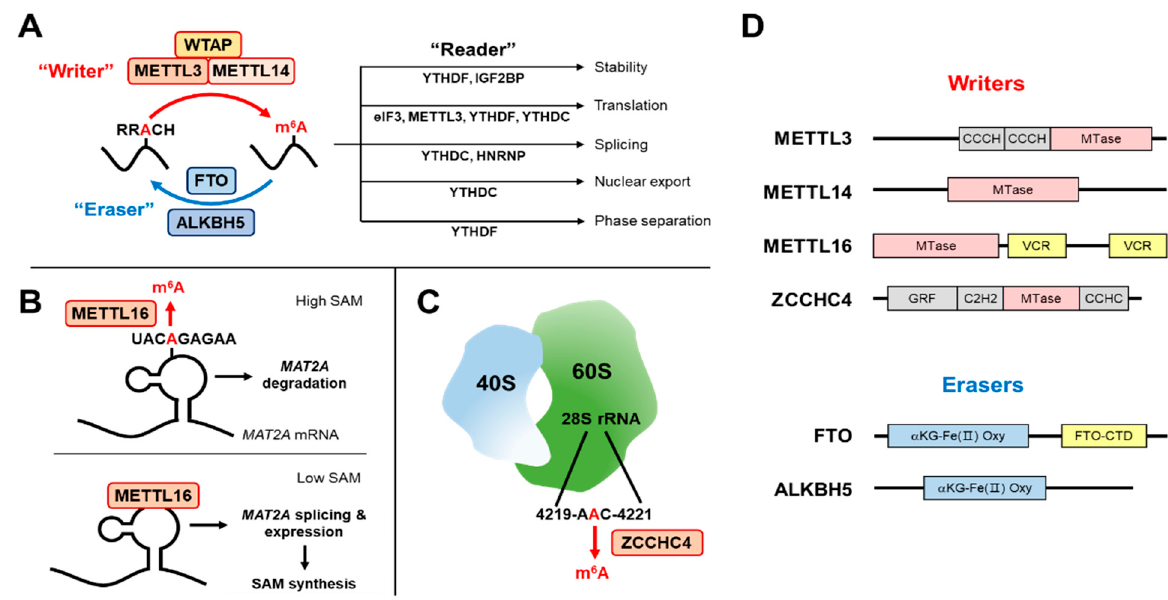
Figure 1. N 6 -methyladenosine (m 6 A) methylation process and its biological functions. ( A ) m 6 A writers (methyltransferase) methylate RNA in the adenine nucleobase of amino group at N 6 position. The consensus motif of methyltransferase-like 3 (METTL3) is RRA*CH (R = A/G; A* = methylated A; H = A/C/U). Once m 6 A is deposited on RNA, m 6 A reader proteins are recruited and determine RNA fates, such as splicing, stability, and translation efficiency, which ultimately affect gene expression. m 6 A is removed from RNA through demethylation by eraser proteins. ( B ) METTL16 methylates stem-loop structure in 3’ untranslated region (UTR) of S -adenosyl methionine (SAM) synthase, methionine adenosyltransferase 2A ( MAT2A ). In SAM-repleted conditions, MAT2A is methylated and degraded. Oppositely, in SAM-depleted conditions, METTL16 induces splicing and expression of MAT2A . ( C ) Methylation of A4220 in 28S ribosomal RNA (rRNA) by zinc finger CCHC domain-containing protein 4 (ZCCHC4) promotes ribosome assembly and translation. ( D ) Domain composition of m 6 A enzymes. (Top, writers) m 6 A writers contain methyltransferase (MTase) domains. METTL3 contains Cys-Cys-Cys-His (CCCH) zinc finger motifs. METTL16 has two vertebrate conserved region (VCR) domains in C-terminus. ZCCHC4 possesses several zinc finger motifs, including Gly-Arg-Phe (GRF), Cys2-His2 (C2H2), and Cys-Cys-His-Cys (CCHC) domains. (Bottom, erasers) Fat mass and obesity-associated protein (FTO) and alkb homolog 5 (ALKBH5) contain α KG- Fe(II)-dependent dioxygenase domains conserved in dioxygenase family enzymes. WTAP, Wilms’ tumor 1-associated protein; eIF3, eukaryotic initiation factor 3; YTHDF, YTH domain family; YTHDC, YTH domain-containing protein; IGF2BP, insulin-like growth factor 2 mRNA-binding protein; HNRNP, heterogeneous nuclear ribonucleoproteins; FTO-CTD, FTO C-terminal